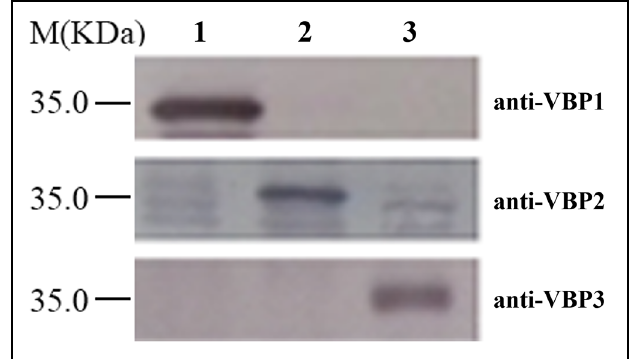
FIGURE 1 | Discrimination of three virD2-binding proteins (VBPs) by Western blot assay. Crude extracts from Escherichia coli cells expressing different vbp genes were separated using SDS-PAGE in the indicated lanes and then analyzed by Western blotting using antibodies against the variable sequence regions of the three VBPs. M: Molecular weight marker. The anti bodies used for each assay are listed on the right. Lane 1: crude extracts from E. coli cells expressing vbp1 . Lane 2: crude extracts from E. coli cells expressing vbp2 . Lane 3: crude extracts from E. coli cells expressing vbp3 .